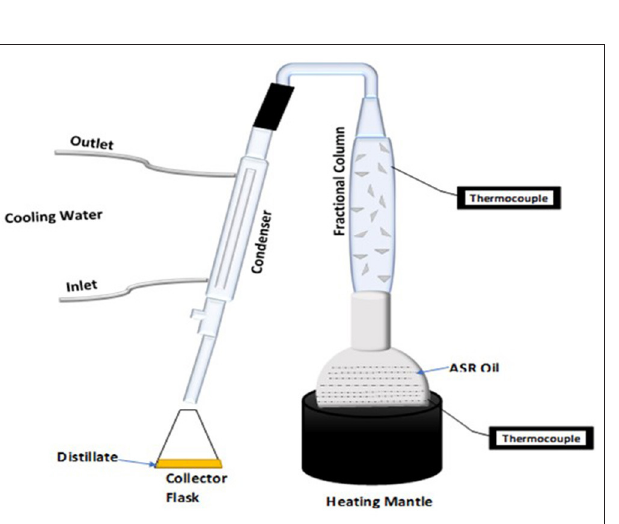
Carbon number distribution in the pyrolysis oil, heavy oil, and distillates was determined using the Shimadzu GC 2010 flame ionization detector fitted with a 30-m length × 0.25-mm ID × 0.25- µ m column. The GC and FID temperatures were 300 ◦ C,